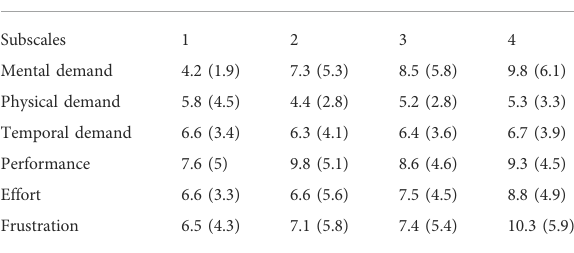
TABLE 2 Comfort/usability ratings (0 – 10 Likert